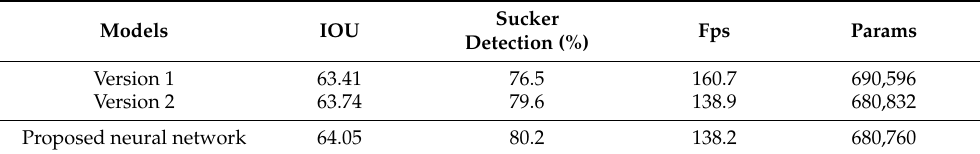
Table 9. Comparison between three different versions of the proposed neural network using depth information and no depth